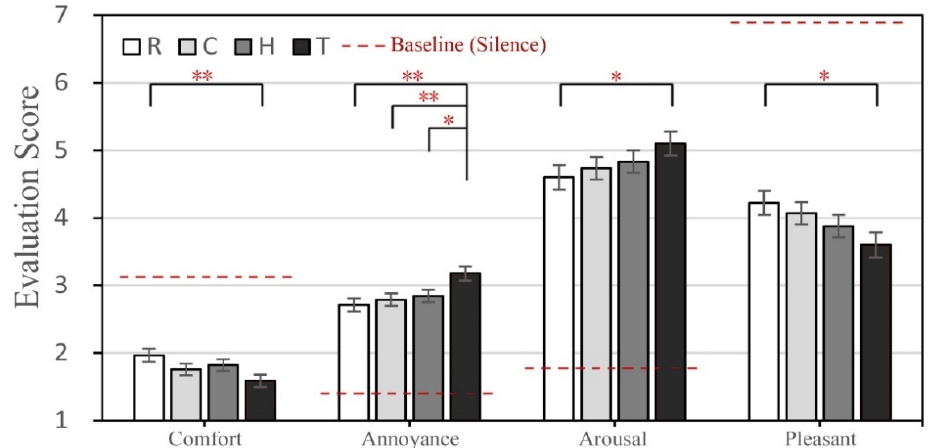
Figure 6. Effect of sound type on psychological attributes. R, C, H, and T represent the road traffic, conventional train, high-speed train, and tram, respectively. The vertical bar represents 95% confidence interval. * and ** represent significant differences in pair-wise comparison (LSD) at a 0.05 level and 0.01 level, respectively.